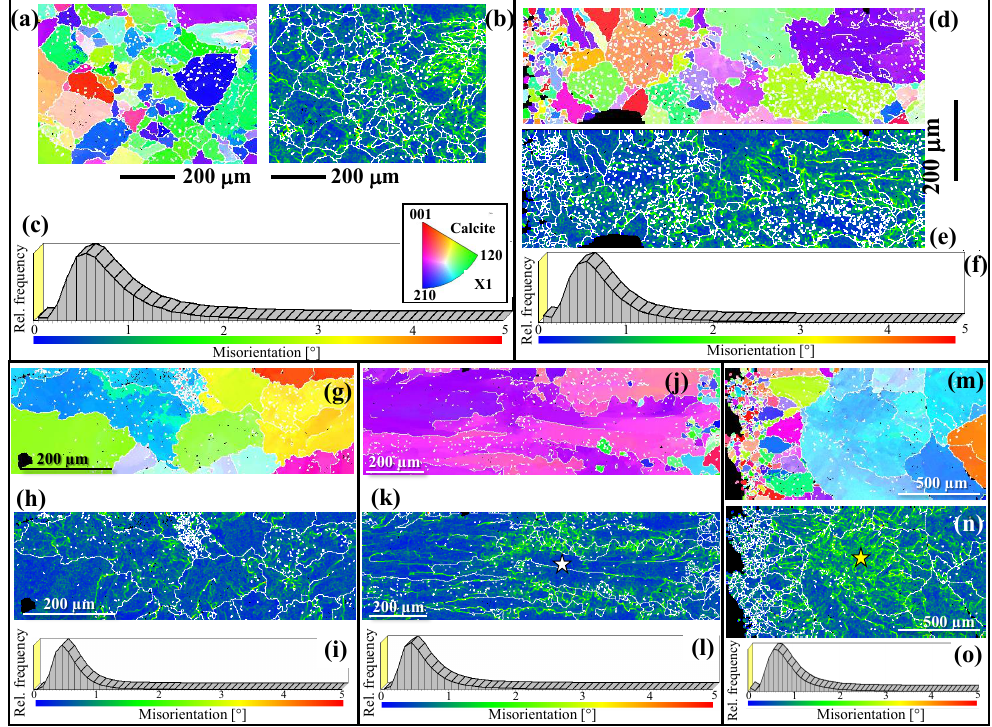
Figure 13. Calcite grain structure ( a, d, g, j, m ; inverse pole figures colours as indicated in the insert in c ) and maps of grain-internal local misorientation distribution ( b, e, ,h, k, n , scales and probability distributions given in c, f, i, l, o ) for experimentally altered shells of A. islandica carried out in simulated meteoric solution at 175 ◦ C for 7 (a–c) and 84 days (d–f) , and in burial solution at 175 ◦ C for 7 (g–l) and 84 days (m–o) . Grains are defined by using a critical misorientation of 5 ◦ . Local misorientation reaches up to 2–3 ◦ (see legends in c, f, i, l, o ), irrespective of alteration duration and solution. The white star in (k) marks stress-free shell portions, while the yellow star in (n) indicates the location of an increased stress